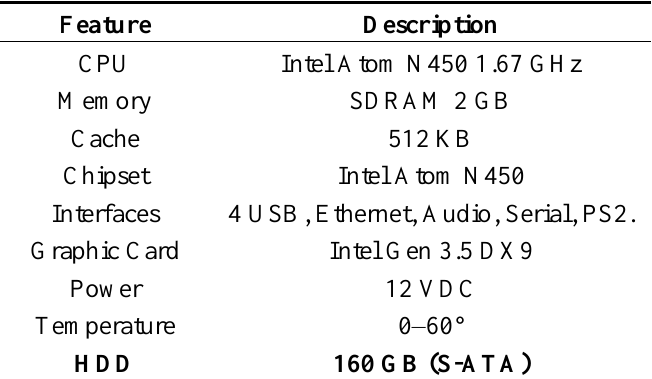
Table 2. Main features of the embedded